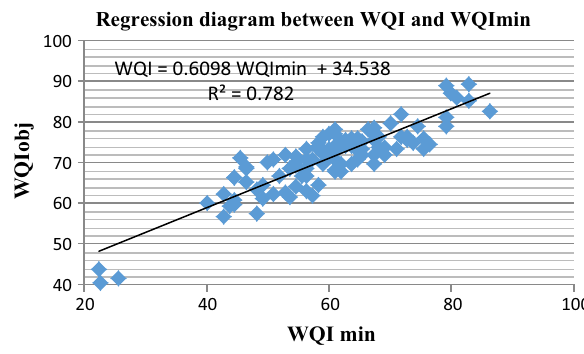
Fig. 2 Regression diagram between WQI obtained from 35 sampling sites in DRB